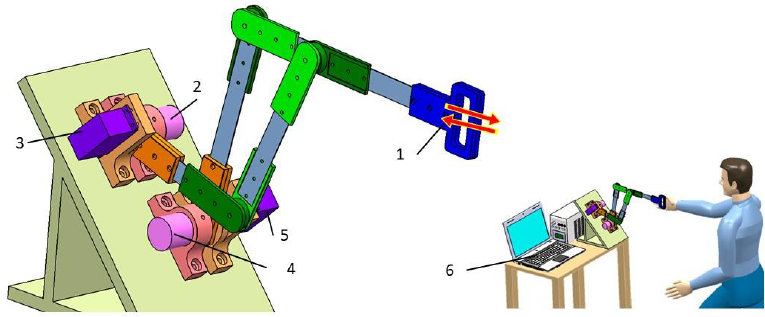
Figure 12. The structure of the haptic mechanism and the mode of operation.